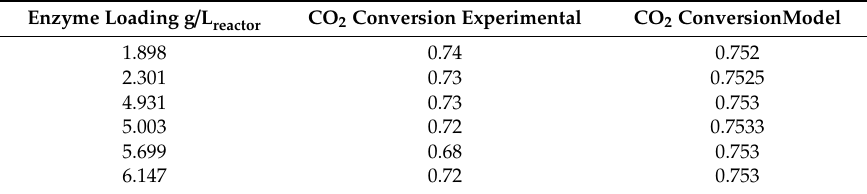
Table 1. Simulated and experimental data for enzymatic CO 2 removal obtained in a structured packed-bed column with immobilized hCA II enzyme on Sulzer Mellapak 500X (experimental data of Rambo et al.